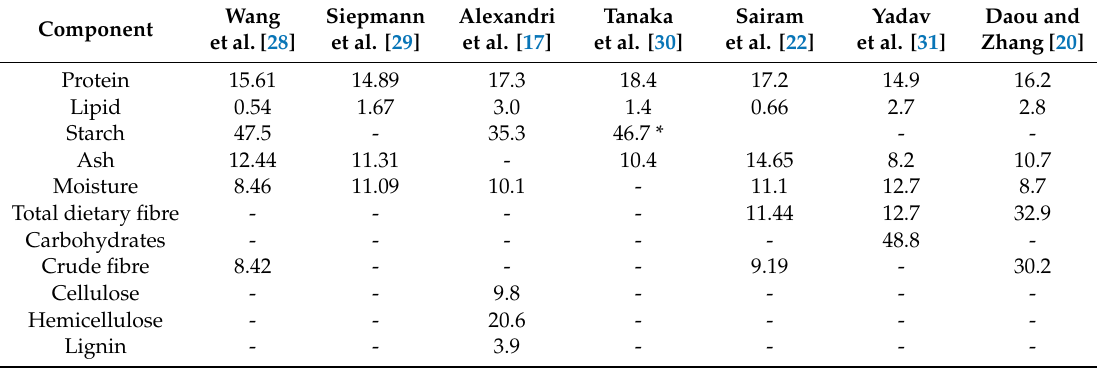
Table 1. Composition (%) of defatted rice bran according to the